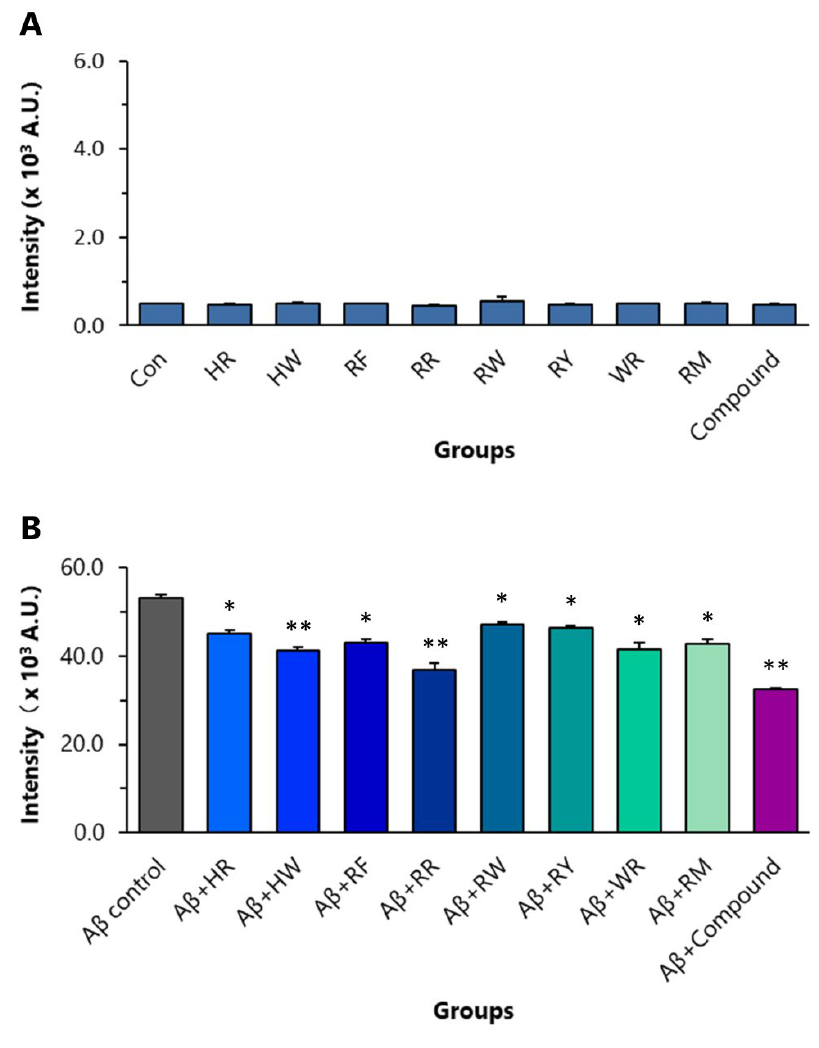
Figure 5. Effects of the eight dipeptides on aggregation of A β 42 . ( A ) Control experiment to show that dipeptides themselves have no effect on ThT fluorescent intensity. ( B ) The effects of the dipeptides on A β 42 aggregation detected by ThT fluorometry. * p < 0.05 and ** p < 0.01 versus A β control group, analyzed by one-way ANOVA followed by the Tukey’s post-hoc test for multiple comparison, n = 5. HR: Histidine-arginine; HW: Histidine–tryptophan; RF: Arginine–